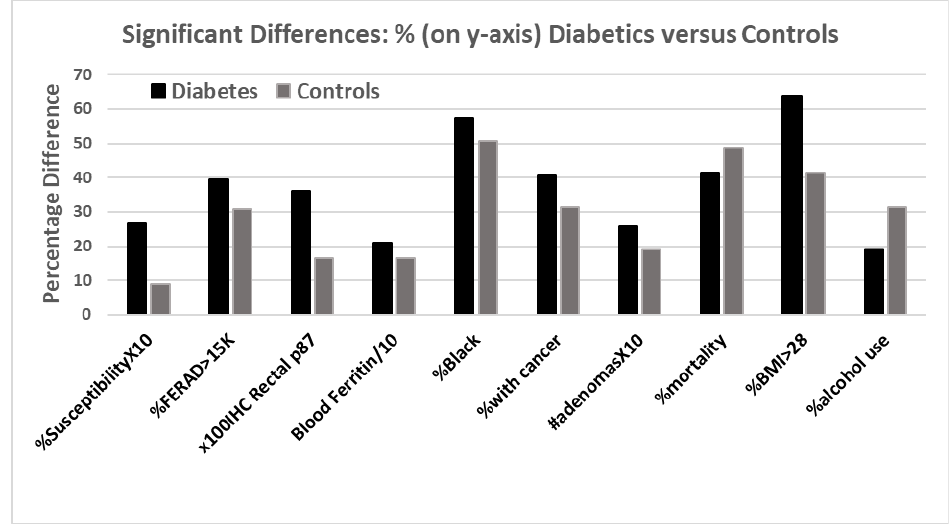
Figure 19. A bar diagram showing significant differences between the patients with DM and con-